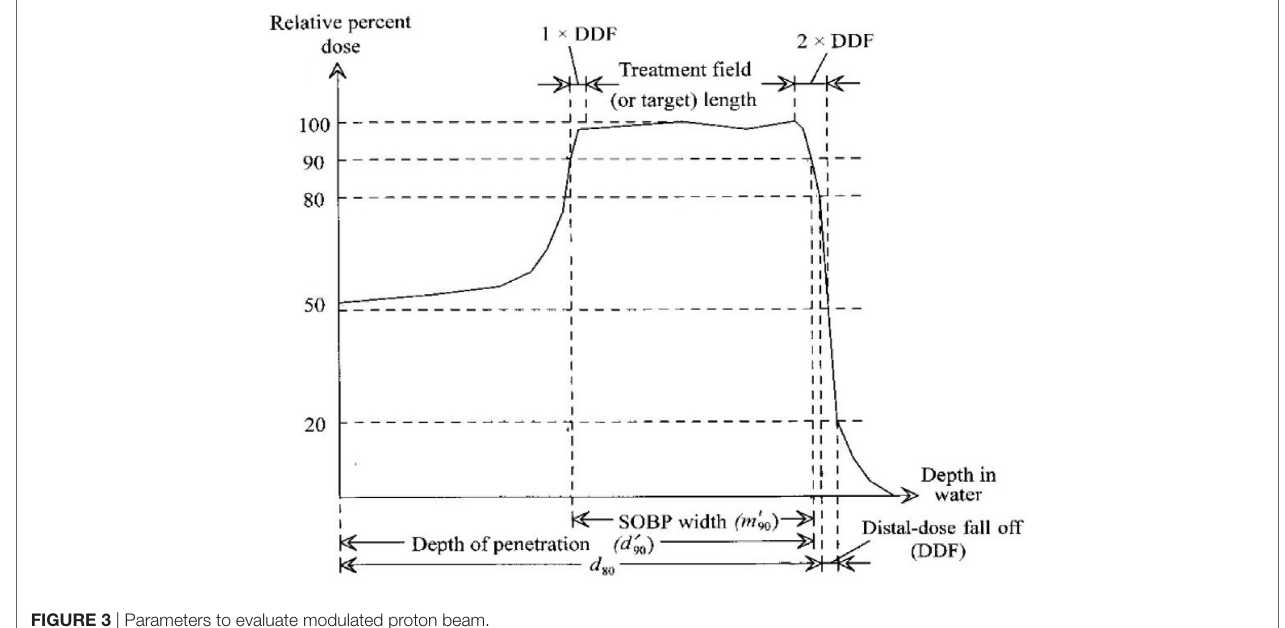
FIgURe 3 | Parameters to evaluate modulated proton